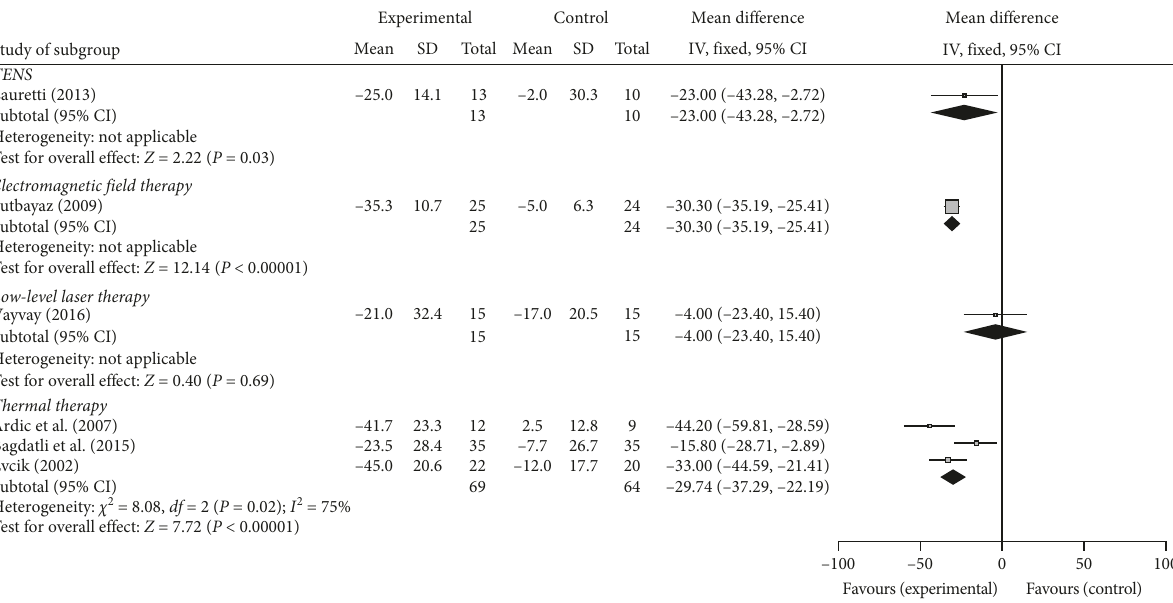
Figure 2: The mean difference and 95% CI of pain relief as measured using a VAS in 6 of the 11 studies for the physical-agent modalities: LLLT, thermal therapies, TENS, and electromagnetic field therapy.